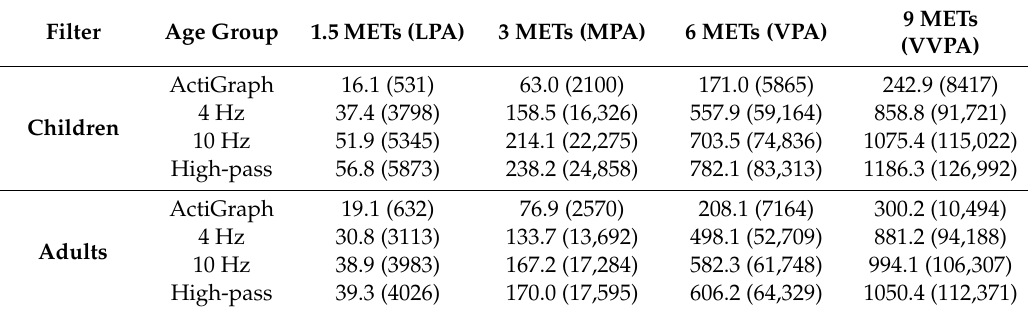
Table 1. Cut-points for acceleration output in mg (counts · min − 1 ) retrieved by evaluating smoothing splines fitted to the acceleration output and energy expenditure for each age